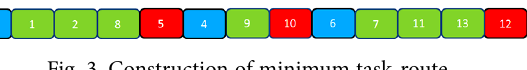
Fig. 3. Construction of minimum task-route (source: created by the authors)